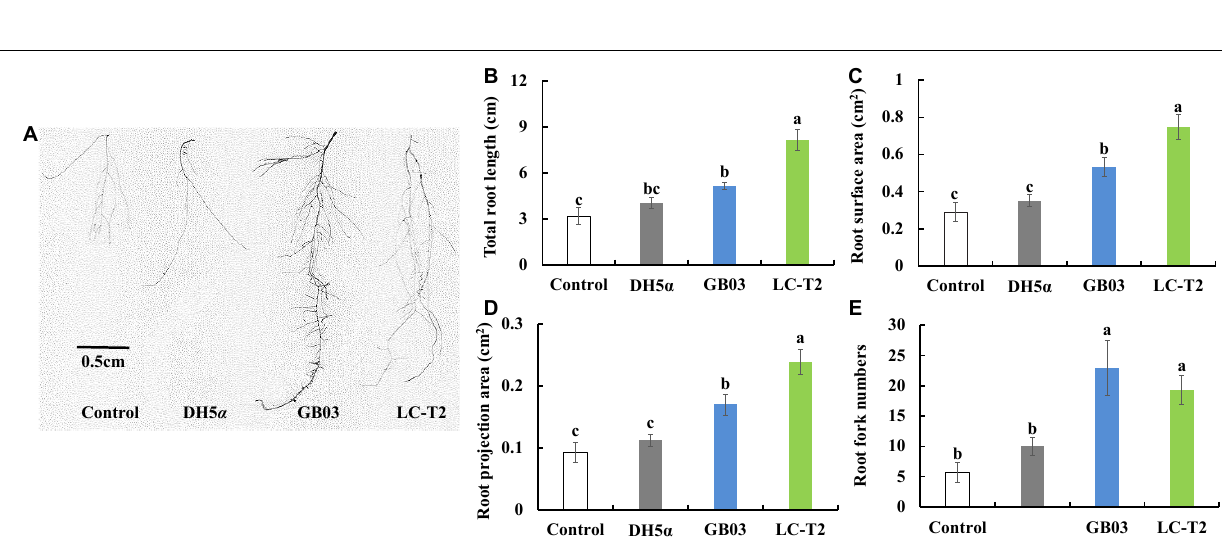
Frontiers in Microbiology |